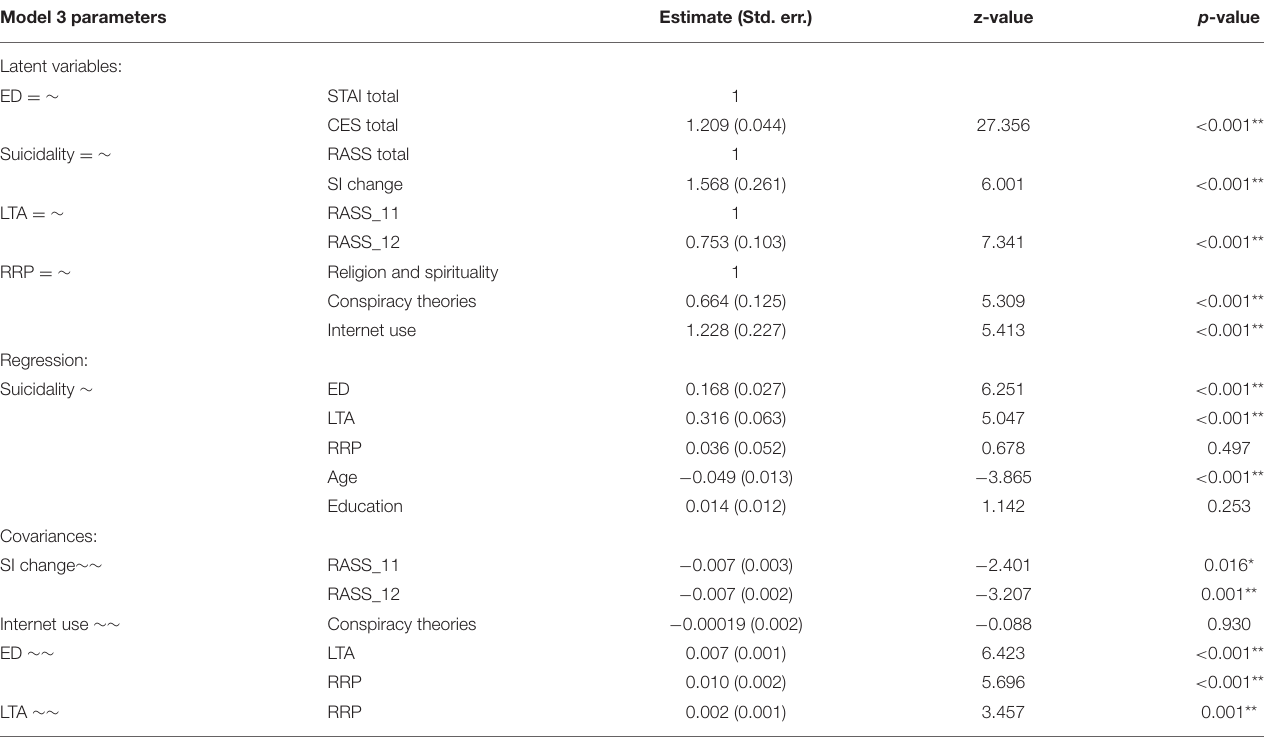
TABLE 7 | The parameters of SEM Model 3 examining the relationships between anxiety, depression, life-threatening attempts, suicidality, religion/spirituality, conspiracy theories, Internet use scorings, age, and education. Model 3 parameters Estimate (Std. err.) z-value p -value